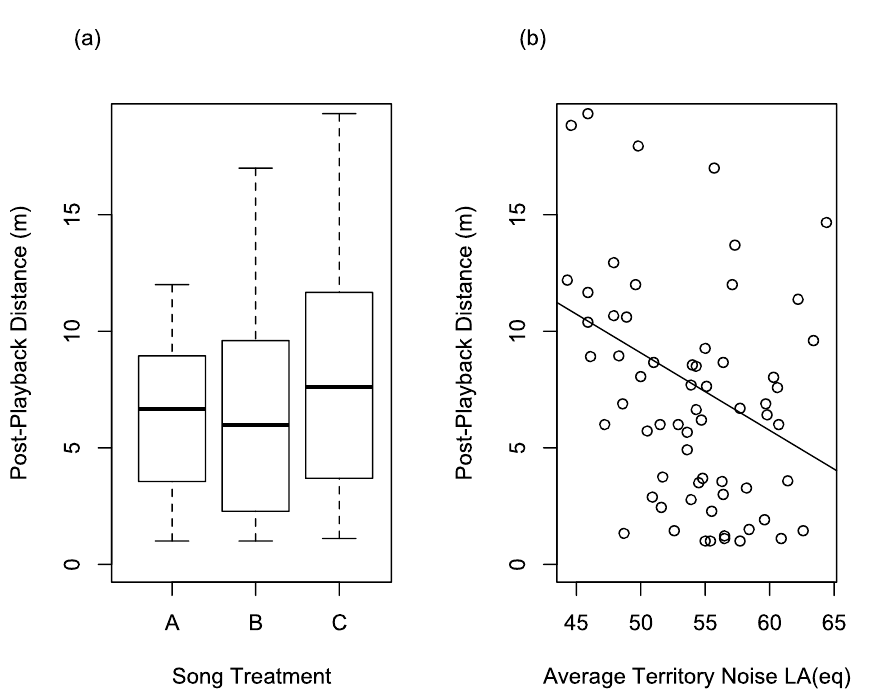
Figure 4. Post-playback approach distance results. ( a ) Boxplot of approach distance for post-playback for three stimulus treatments: (A) fast trill, wide bandwidth (7.11 ± 0.96 m), (B) fast trill, narrow bandwidth (7.54 ± 1.41 m), and (C) slow trill, wide bandwidth (8.54 ± 1.19 m). All post-hoc comparisons between treatments p > 0.05. ( b ) Linear regression of male approach distance during post-playback and territory noise ( β = − 0.05, p =